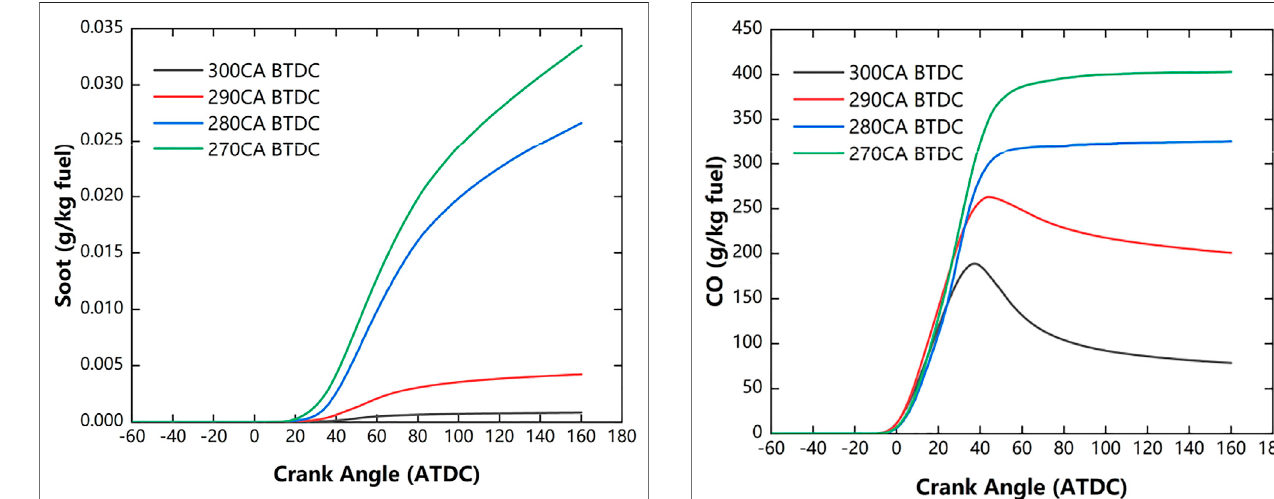
FIGURE 17 | Effect of injection timing on CO